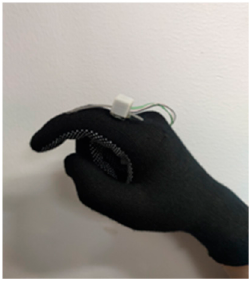
Figure 11. Response of the sensing unit on the wooden finger model.